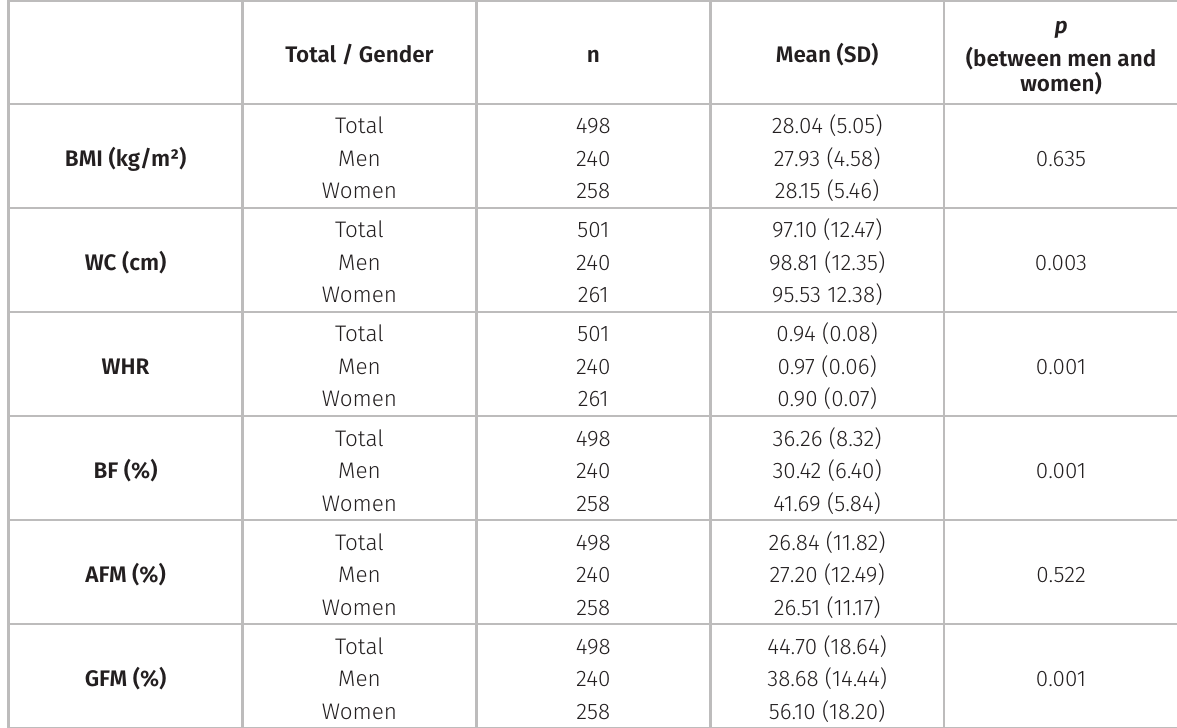
Table I. Descriptive characteristics of the population sample containing means and standard deviations of total sample and between men and women for each obesity-related